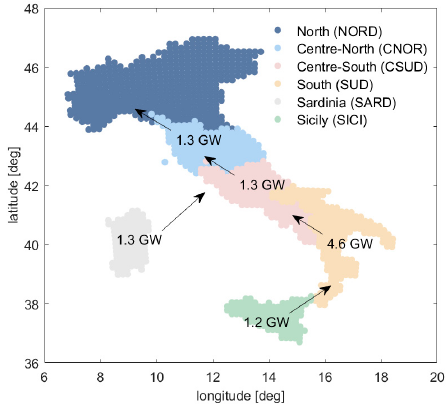
Figure 1. Italian markets zones and transmission lines capacity limits from Sicily to Nord 2019. Figure adapted and re-edited from [46].